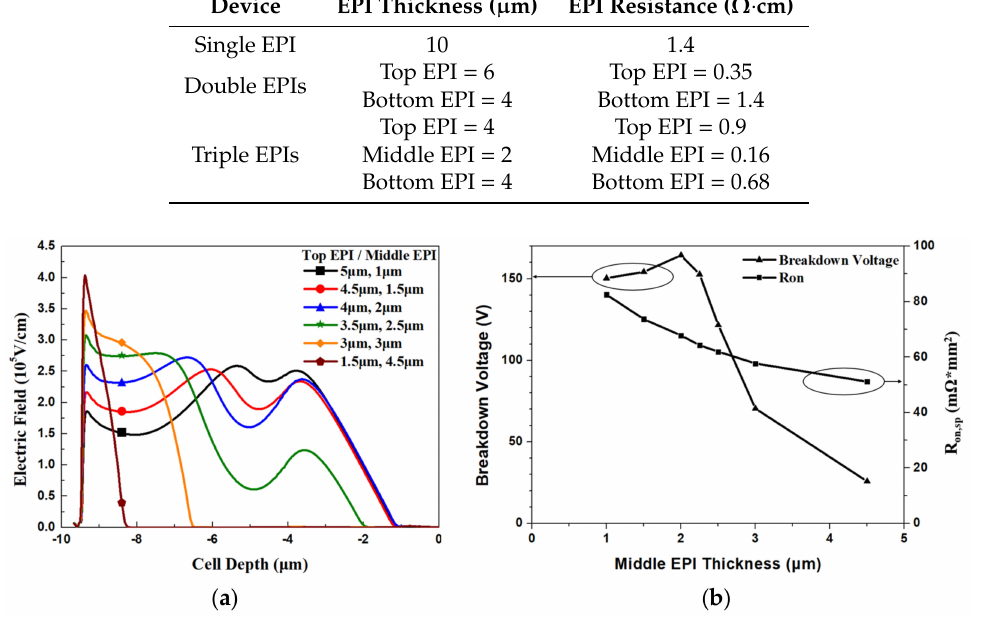
Figure 4. ( a ) The simulated electric field curves in the middle of the cell and ( b ) the simulated V BR and R on,sp with di ff erent top- and middle-EPI-thickness designs with the same total and bottom EPI